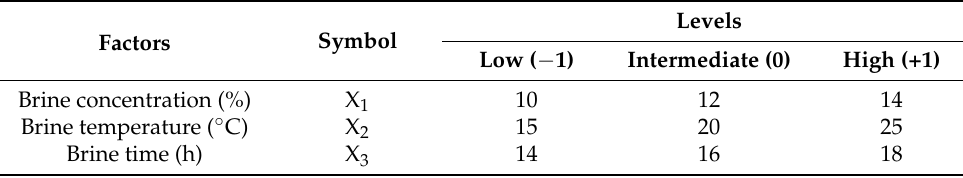
Table 1. Factors and levels used in the Box–Behnken design matrix for the brining process for the Kimchi